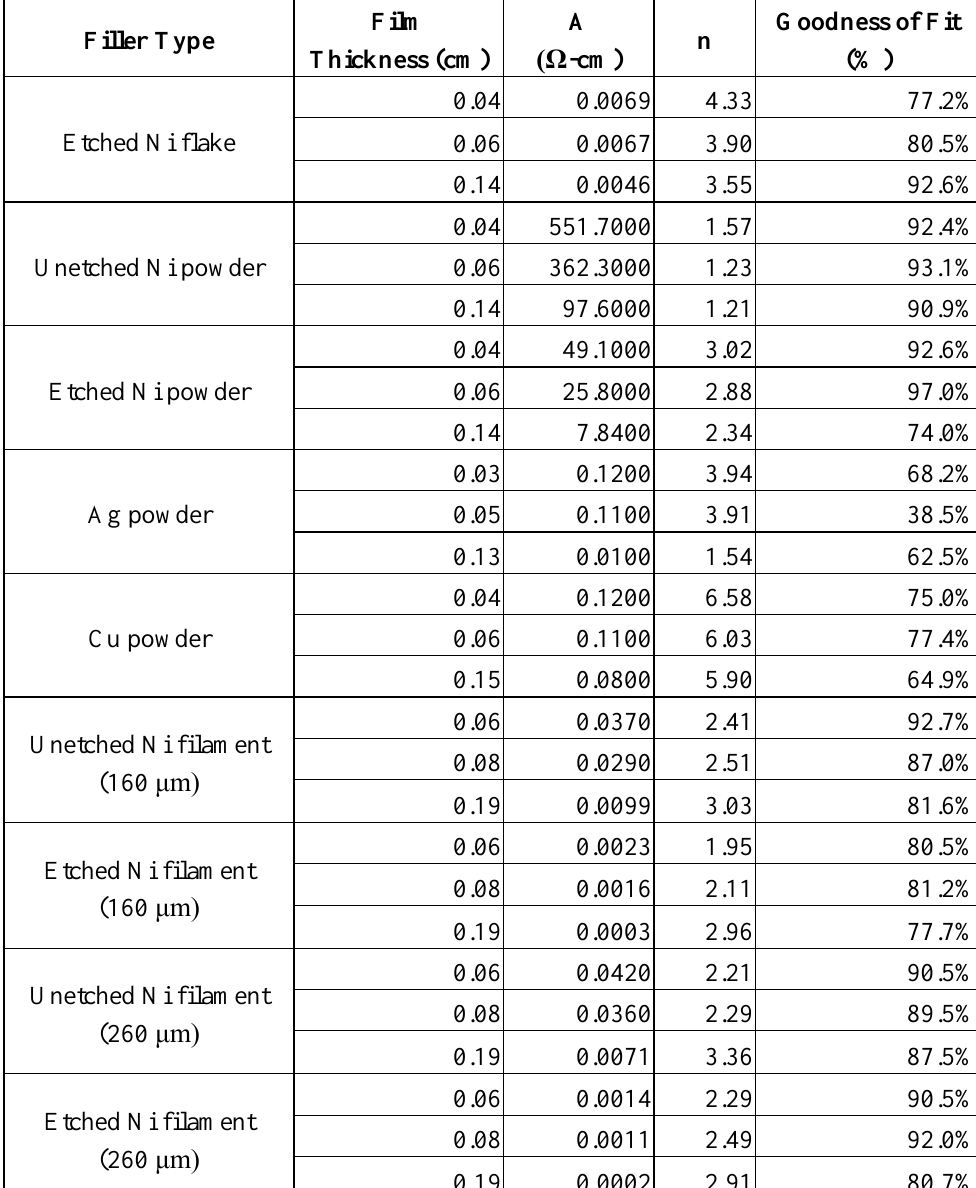
Table 4. The material parameters of the 2-parameter power function  = A/  n , describing the volume fraction (  )-dependent conduction behavior with various conductive particles in Epon 830